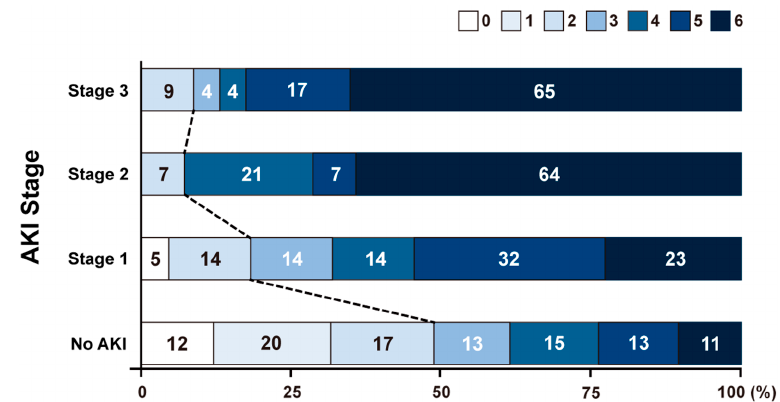
Figure 2. Modified Rankin Scale at 3 months according to acute kidney injury stage. AKI, acute kidney injury.